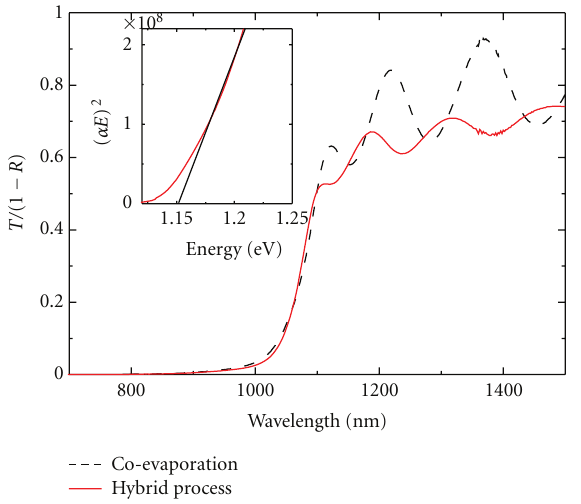
Figure 4: Room temperature T/ (1 − R ) spectra of 2 μ m thick Cu(In,Ga)Se 2 films; the inset is a plot of ( αE ) 2 versus E for the hybrid deposited sample.